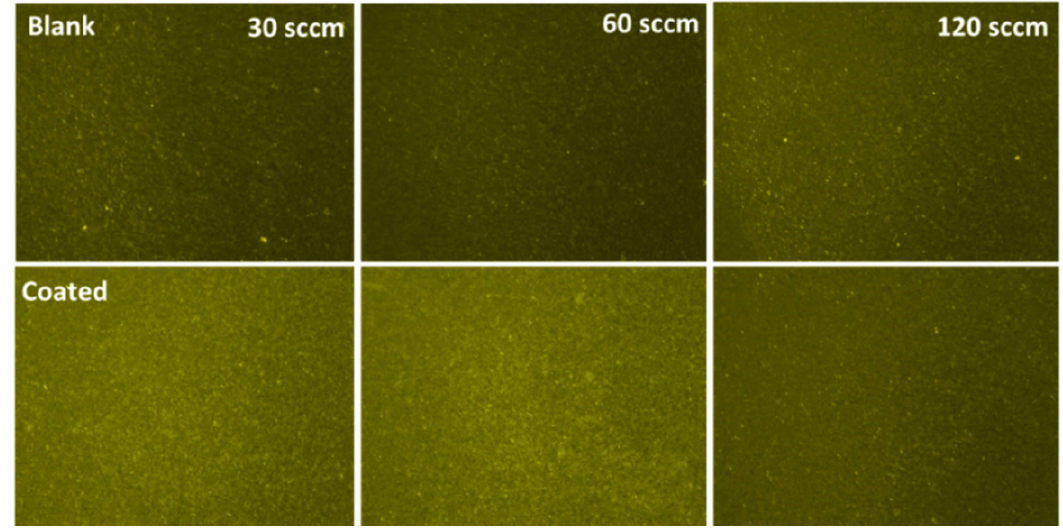
Figure 7. Fluorescence images of functionalized p-GaN surfaces with Cp 2 Mg injection levels of 30 sccm,